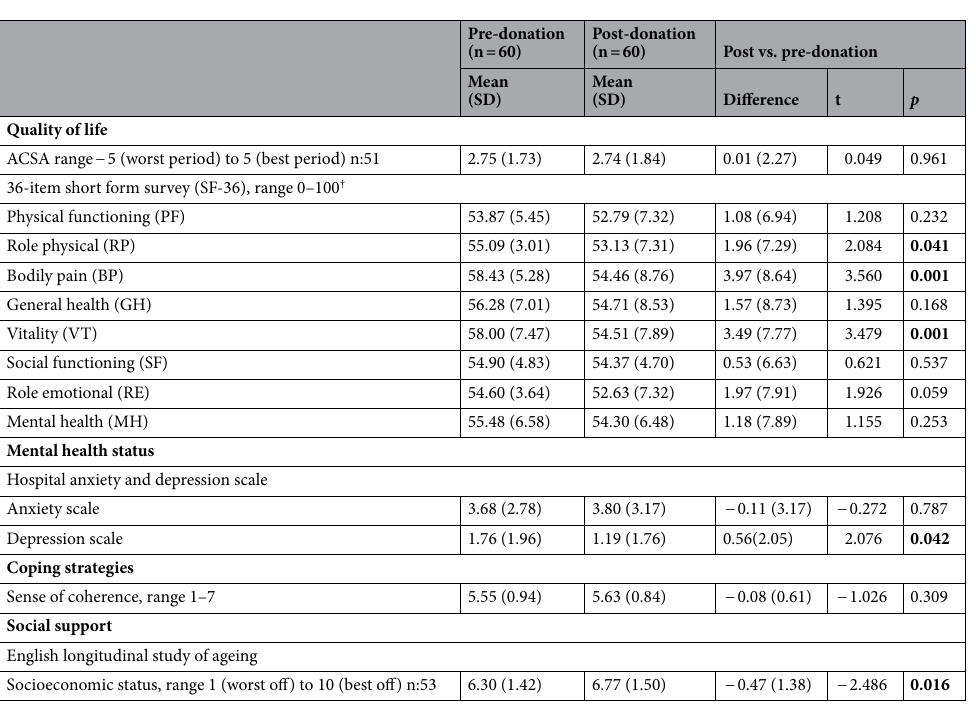
Table 4. Differences between pre-donation and post-donation assessment. † SF-36 T scores (> 55 is higher than average, < 45 is lower than